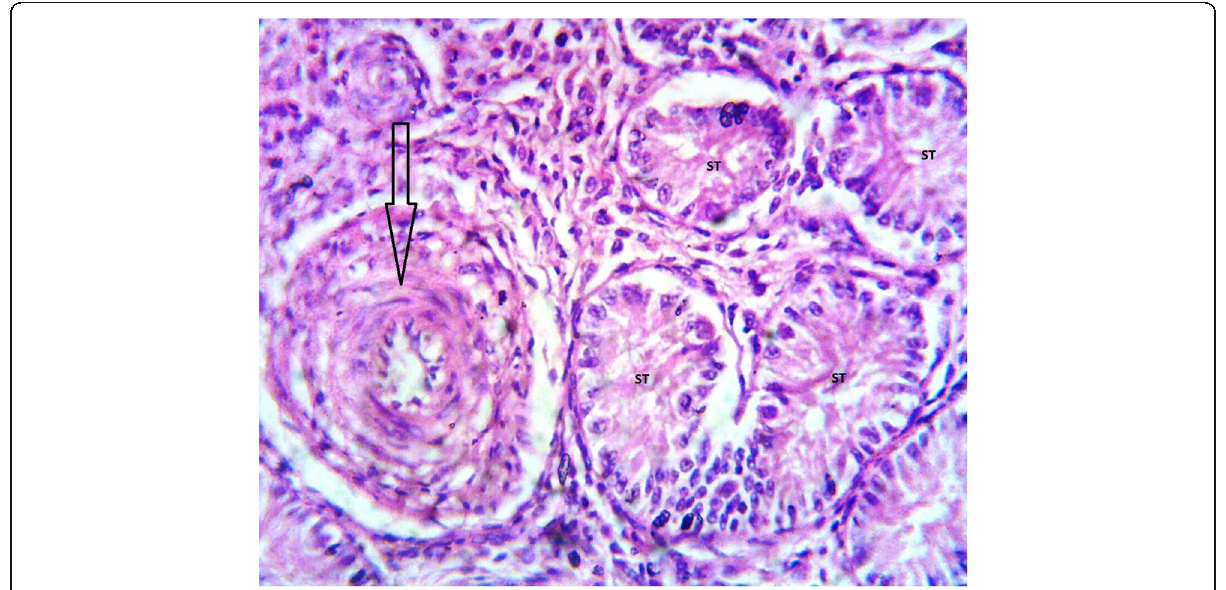
Fig. 12 Representative micrograph of testis section (× 400) of broiler chicks fed 1.0% PCM supplemented diet. This section appears as in Fig. 11 above. The blood vessels show medial hypertrophy